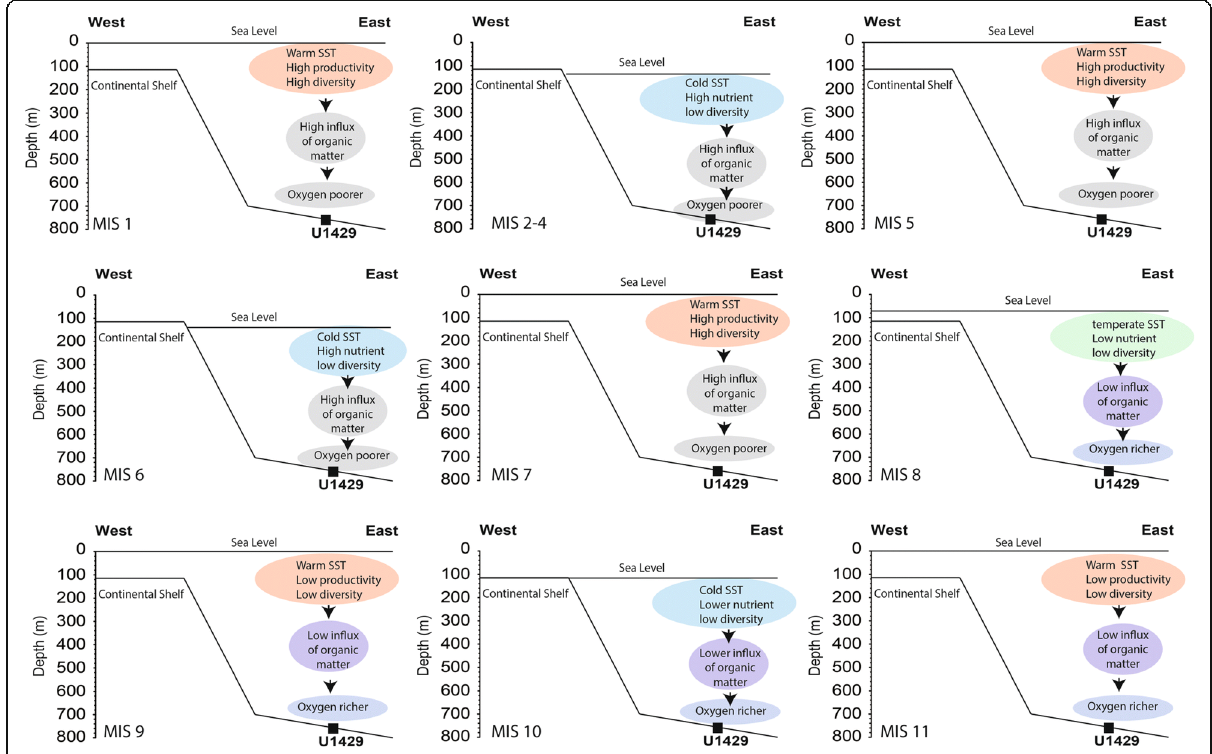
Fig. 8 Postulated hydrographic evolution of the northern ECS over the last 400